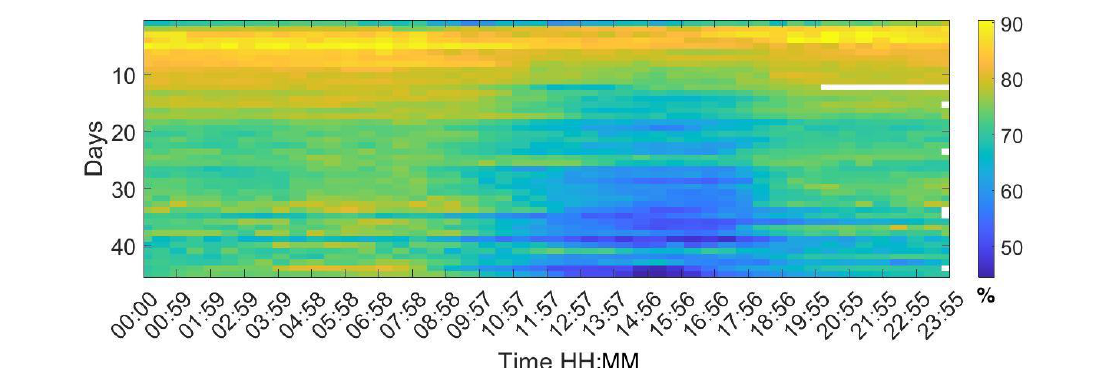
Figure 10. Map of the humidity values for each day of the campaign. The horizontal axis shows the hours of the day and night, displaying a value every 30 min, and the vertical axis shows the days of the